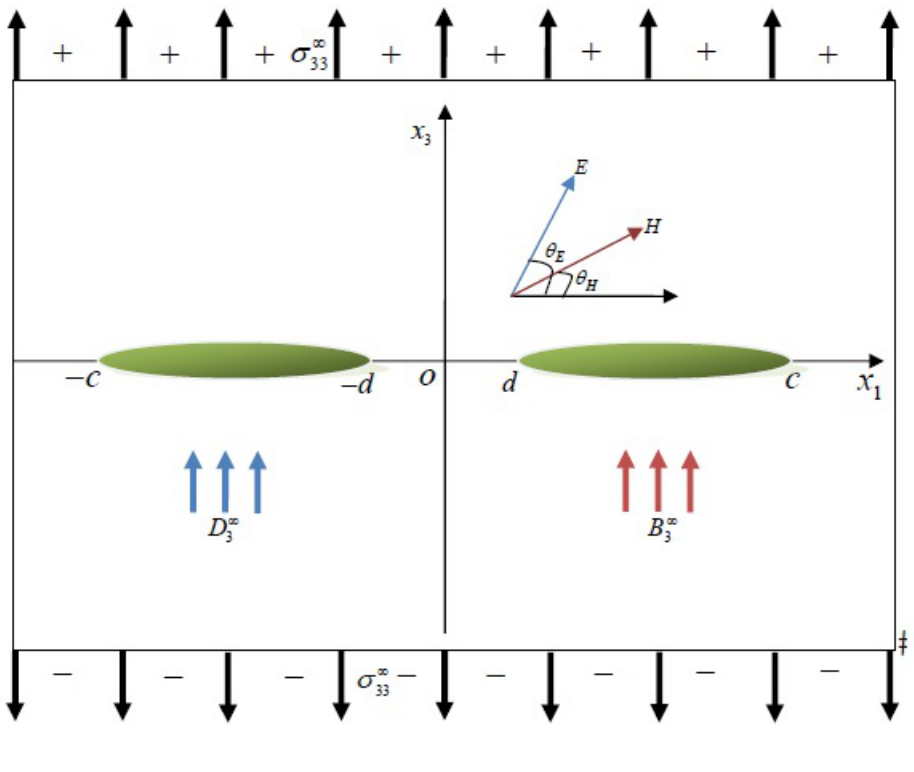
Fig. 1 Schematic representation of the